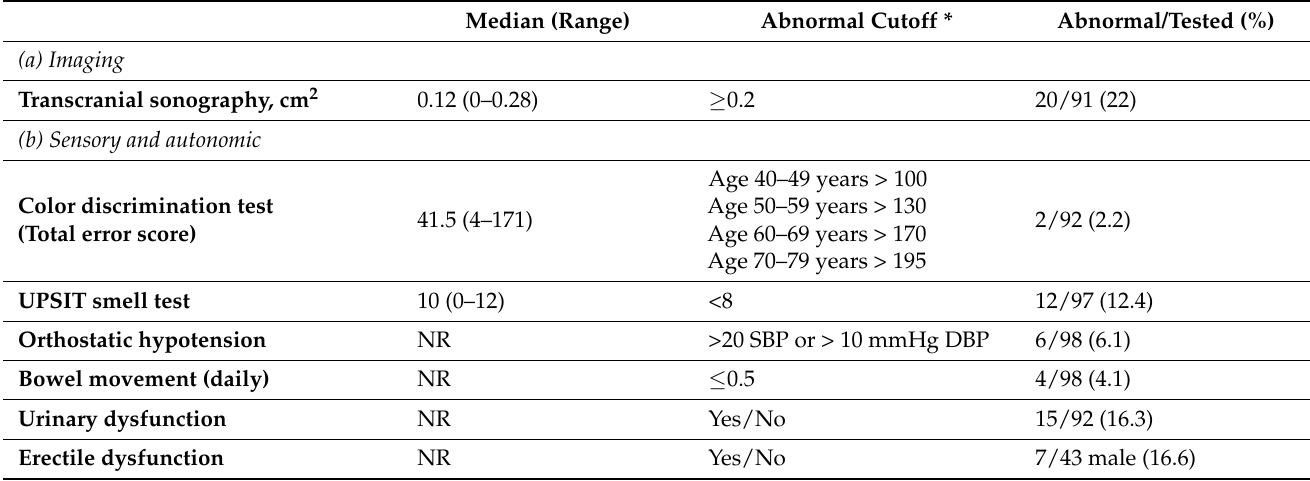
Table 2. Median (range) and rate of abnormal prodromal tests in the five